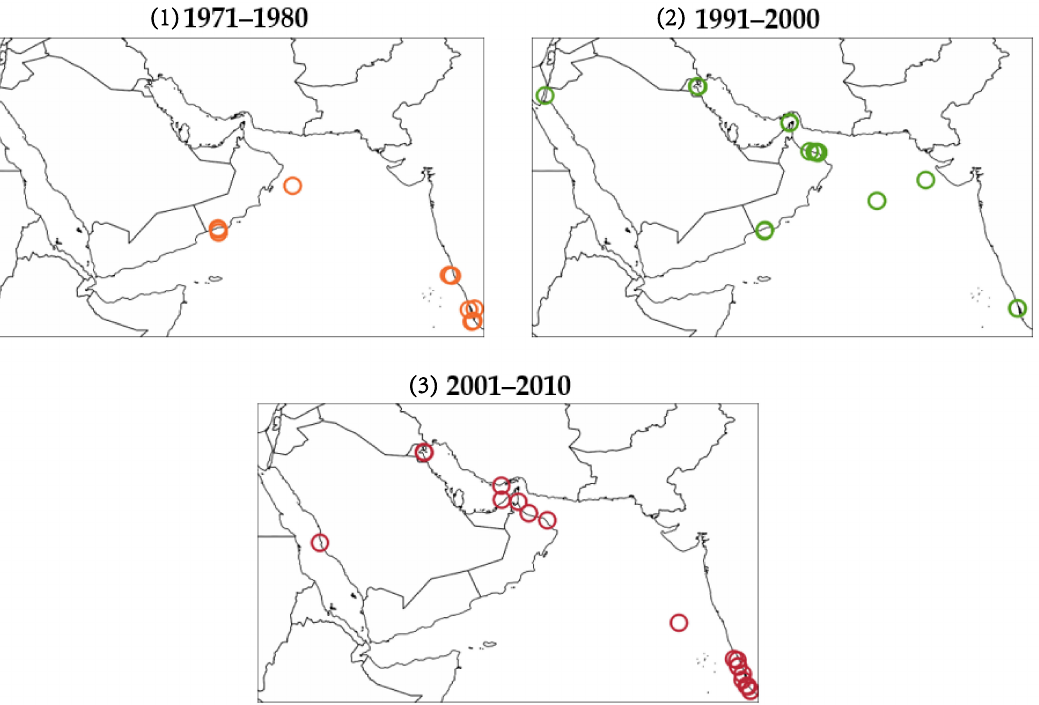
Figure A2. Algal bloom outbreaks in the NIO during June–August over four decades: ( 1 ) 1971–1980, ( 2 ) 1991–2000, and ( 3 )